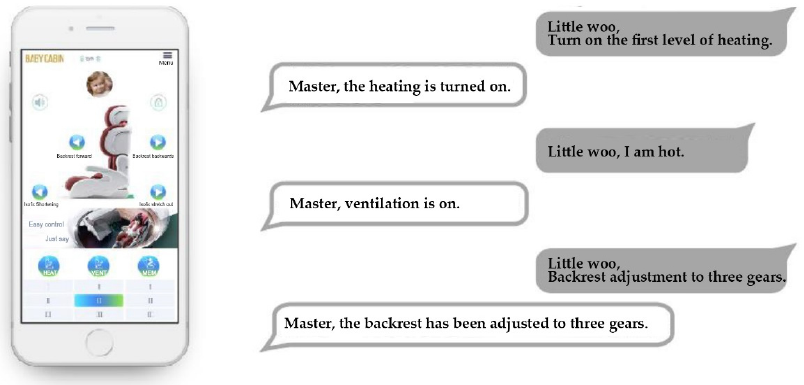
Figure 9. It can be controlled using speech.